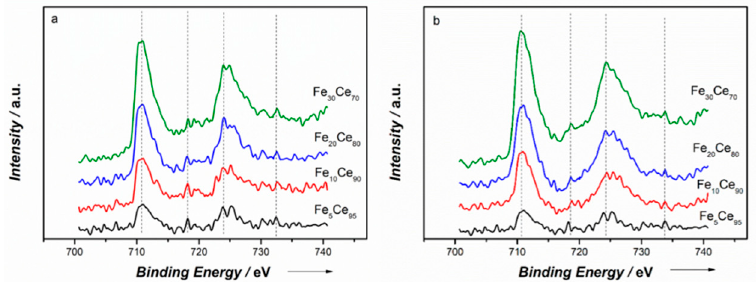
Figure 4. XPS spectra of Fe2p: ( a ) Co-precipitation method, ( b ) solution combustion synthesis method.